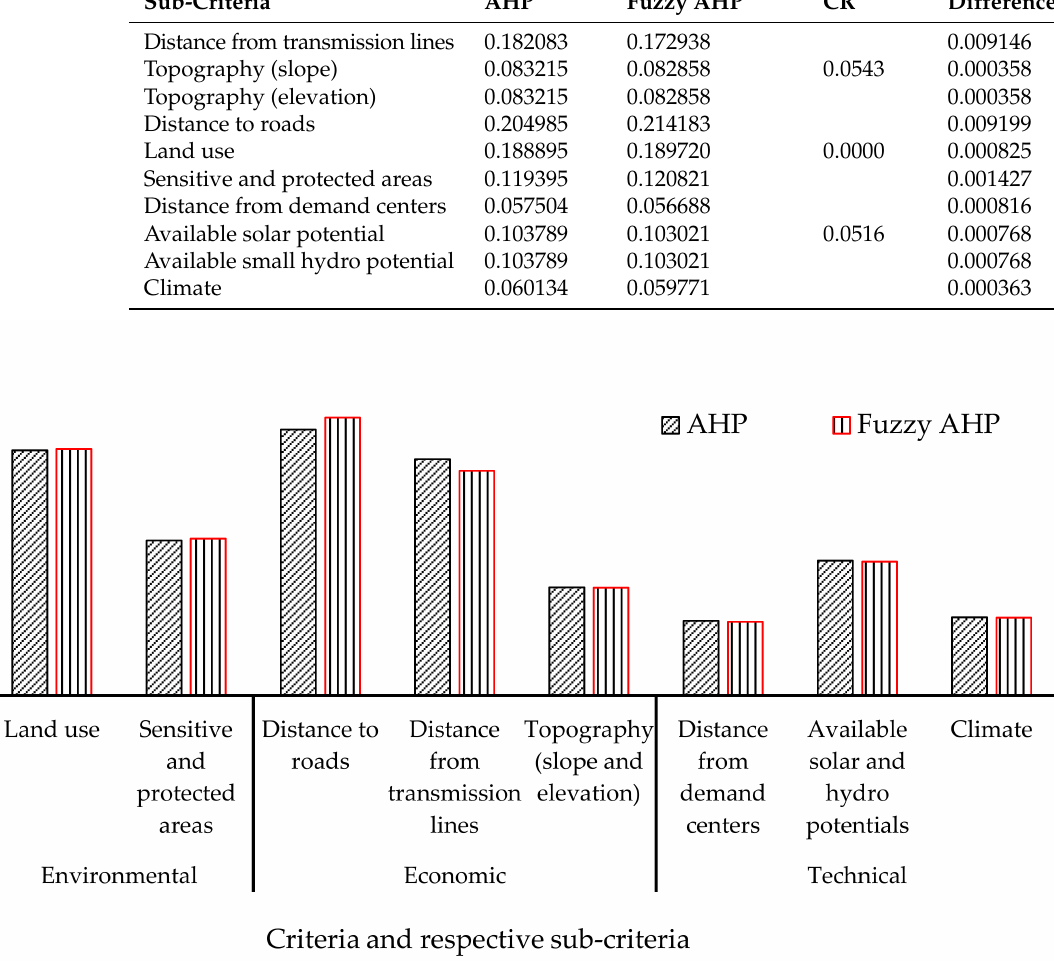
Figure 15. The patterns of weight results for AHP and fuzzy AHP